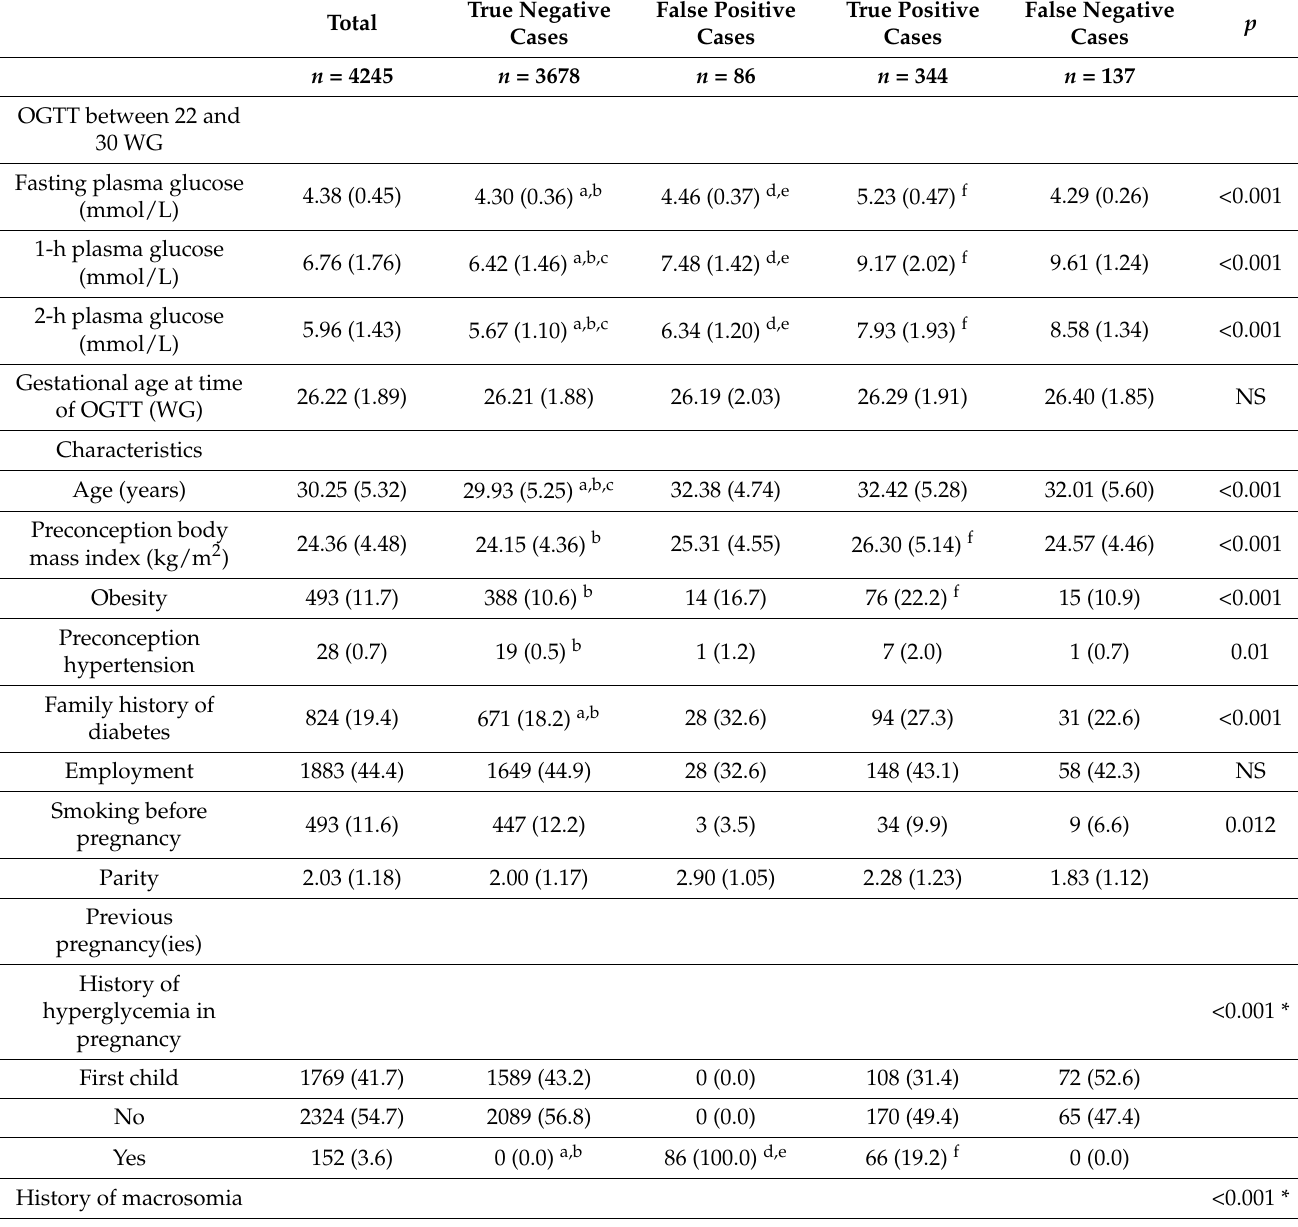
Table 1. Characteristics of the women by true/false positive/negative cases considering Option 2. True Negative Total